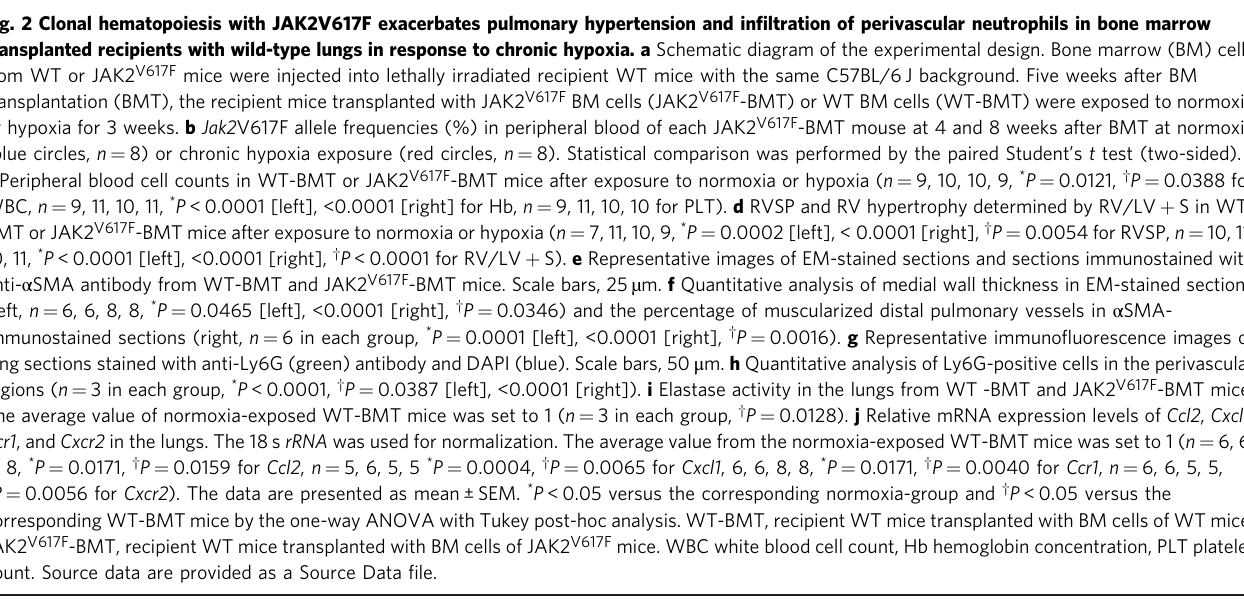
Fig. 2 Clonal hematopoiesis with JAK2V617F exacerbates pulmonary hypertension and in fi ltration of perivascular neutrophils in bone marrow transplanted recipients with wild-type lungs in response to chronic hypoxia. a Schematic diagram of the experimental design. Bone marrow (BM) cells from WT or JAK2 V617F mice were injected into lethally irradiated recipient WT mice with the same C57BL/6 J background. Five weeks after BM transplantation (BMT), the recipient mice transplanted with JAK2 V617F BM cells (JAK2 V617F -BMT) or WT BM cells (WT-BMT) were exposed to normoxia or hypoxia for 3 weeks. b Jak2 V617F allele frequencies (%) in peripheral blood of each JAK2 V617F -BMT mouse at 4 and 8 weeks after BMT at normoxia (blue circles, n = 8) or chronic hypoxia exposure (red circles, n = 8). Statistical comparison was performed by the paired Student ’ s t test (two-sided). c Peripheral blood cell counts in WT-BMT or JAK2 V617F -BMT mice after exposure to normoxia or hypoxia ( n = 9, 10, 10, 9, * P = 0.0121, † P = 0.0388 for WBC, n = 9, 11, 10, 11, * P < 0.0001 [left], <0.0001 [right] for Hb, n = 9, 11, 10, 10 for PLT). d RVSP and RV hypertrophy determined by RV/LV + S in WT- BMT or JAK2 V617F -BMT mice after exposure to normoxia or hypoxia ( n = 7, 11, 10, 9, * P = 0.0002 [left], < 0.0001 [right], † P = 0.0054 for RVSP, n = 10, 11, 10, 11, * P < 0.0001 [left], <0.0001 [right], † P < 0.0001 for RV/LV + S). e Representative images of EM-stained sections and sections immunostained with anti- α SMA antibody from WT-BMT and JAK2 V617F -BMT mice. Scale bars, 25 µ m. f Quantitative analysis of medial wall thickness in EM-stained sections (left, n = 6, 6, 8, 8, * P = 0.0465 [left], <0.0001 [right], † P = 0.0346) and the percentage of muscularized distal pulmonary vessels in α SMA- immunostained sections (right, n = 6 in each group, * P = 0.0001 [left], <0.0001 [right], † P = 0.0016). g Representative immuno fl uorescence images of lung sections stained with anti-Ly6G (green) antibody and DAPI (blue). Scale bars, 50 μ m. h Quantitative analysis of Ly6G-positive cells in the perivascular regions ( n = 3 in each group, * P < 0.0001, † P = 0.0387 [left], <0.0001 [right]). i Elastase activity in the lungs from WT -BMT and JAK2 V617F -BMT mice. The average value of normoxia-exposed WT-BMT mice was set to 1 ( n = 3 in each group, † P = 0.0128). j Relative mRNA expression levels of Ccl2 , Cxcl1 , Ccr1 , and Cxcr2 in the lungs. The 18 s rRNA was used for normalization. The average value from the normoxia-exposed WT-BMT mice was set to 1 ( n = 6, 6, 8, 8, * P = 0.0171, † P = 0.0159 for Ccl2 , n = 5, 6, 5, 5 * P = 0.0004, † P = 0.0065 for Cxcl1 , 6, 6, 8, 8, * P = 0.0171, † P = 0.0040 for Ccr1 , n = 6, 6, 5, 5, † P = 0.0056 for Cxcr2 ). The data are presented as mean ± SEM. * P < 0.05 versus the corresponding normoxia-group and † P < 0.05 versus the corresponding WT-BMT mice by the one-way ANOVA with Tukey post-hoc analysis. WT-BMT, recipient WT mice transplanted with BM cells of WT mice; JAK2 V617F -BMT, recipient WT mice transplanted with BM cells of JAK2 V617F mice. WBC white blood cell count, Hb hemoglobin concentration, PLT platelet count. Source data are provided as a Source Data fi